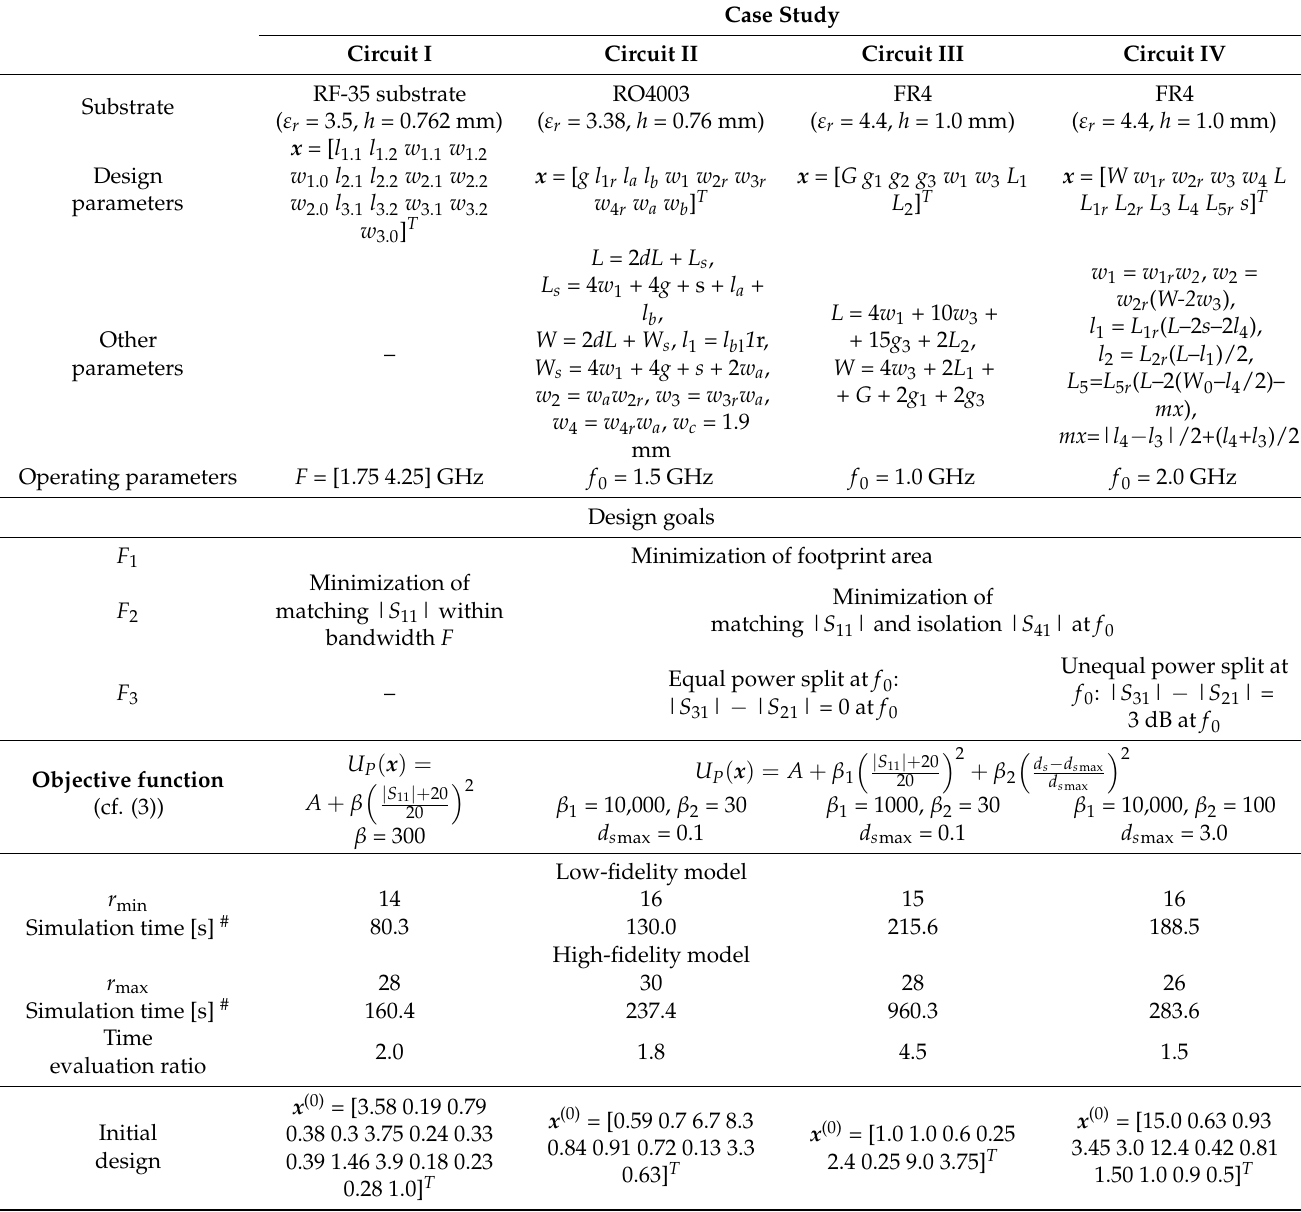
Table 2. Details of microwave structures used as verification